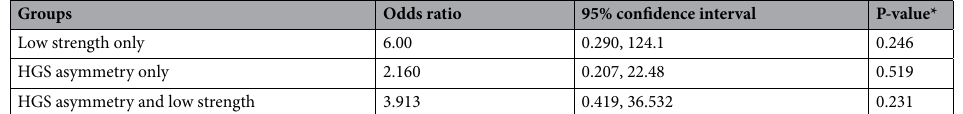
Table 6. The association between “low strength” and “HGS asymmetry” and functional limitations. *Logistic regression.